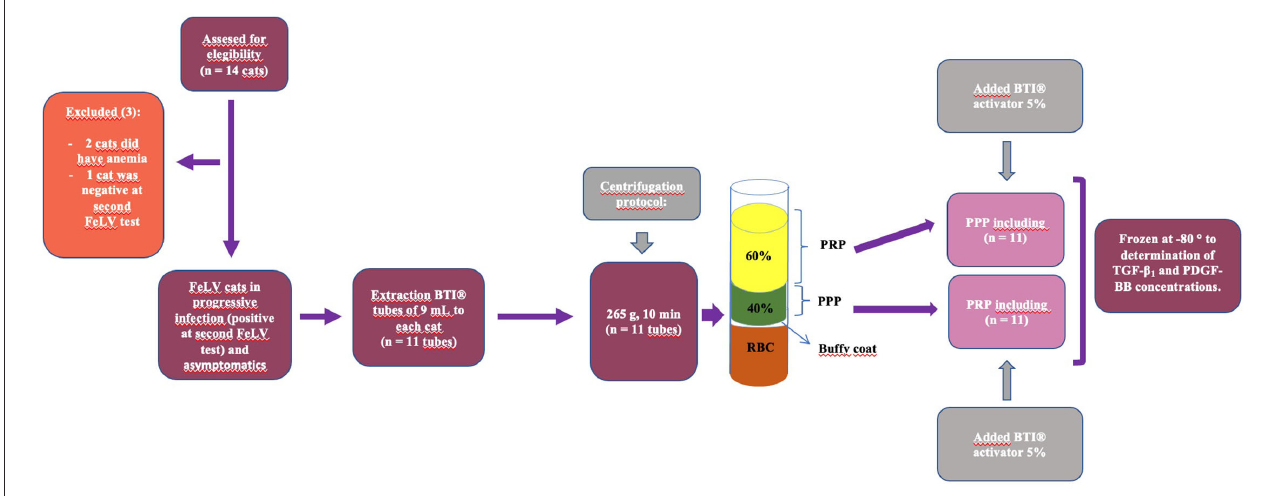
FIGURE1 Schematization of the study design: blood sample obtention, centrifugation following feline BTI protocol using the PRGF ® -Endoret ® methodology, PRP and PPP fraction obtention, subsequent activation of both fractions with BTI-activator and freezing at − 80 ◦ C for subsequent GFs